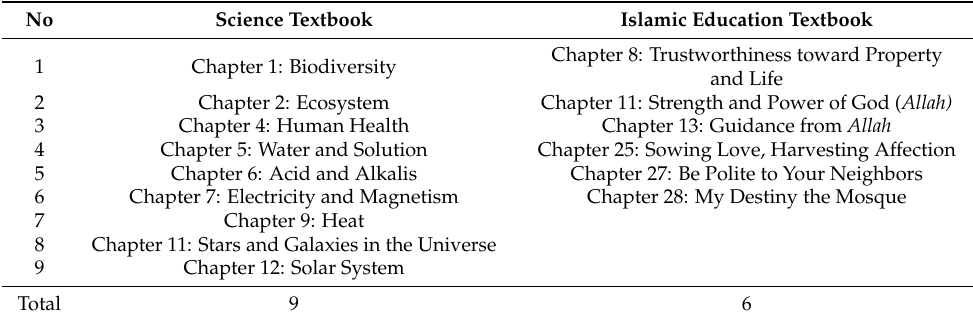
Table 1. Analysis of chapter titles that contain integration of Islamic values for environmental